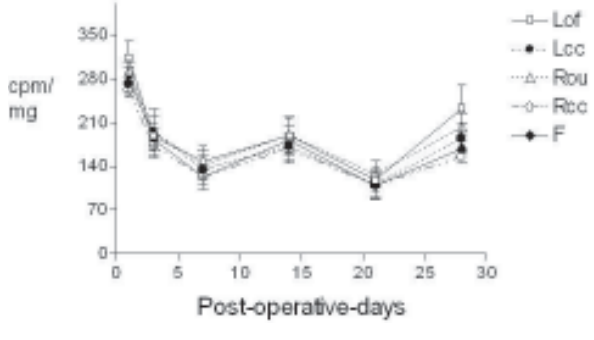
in tibiae and femurs of rats. FIGURE 2- Uptake of Na 99m TcO 4 The tracer ( ca. 500 µ Ci) was injected i.v. and the animals were sacrificed 2 h later. Radioactivity (in cpm) was counted in fragments of tibiae which included the surgical defect and in contiguous, defect-free segments. A distant, naïve bone fragment (femur) was also counted, for control. Left tibial defects were filled with freeze-dried bone; the right in femurs of FIGURE 3- Uptake of 99m Tc-MDP and Na 99m TcO 4 ones were left unfilled, and groups of animals (n = 6 in rats. The tracers ( ca. 500 µ Ci) were injected i.v. in parallel every group) were sacrificed at the indicated times after groups of animals which were sacrificed 2 h later. Values surgery. Abbreviations: Lof = left, operated, filled; Lcc = left, are mean ± SEM (cpm/mg wet weight) of data from 6 animals for every group. Asterisks indicate significant contiguous, control; Rou = right, operated, unfilled; Rcc = differences regarding the corresponding points right, contiguous, control; F = femur. Values are mean ± SEM (cpm/mg wet weight)